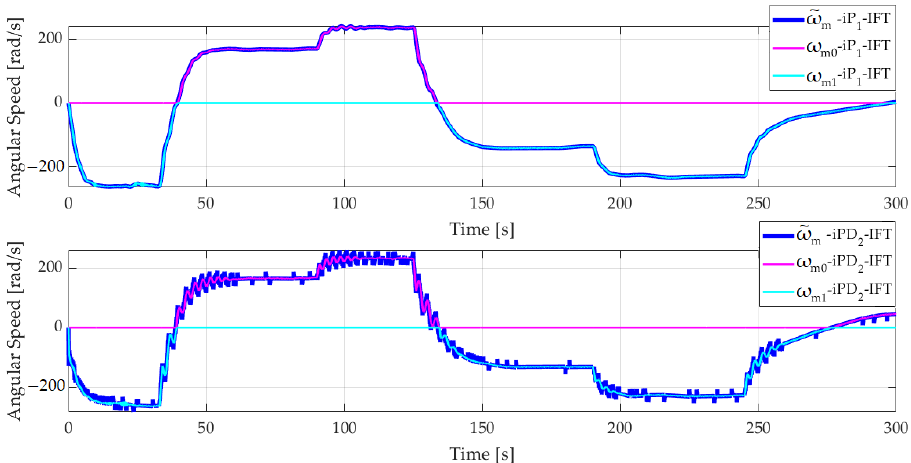
Figure 12. Control signals of iP 1 -IFT and iPD 2 -IFT and the controlled angular speeds for the pitch angle variation experiments.